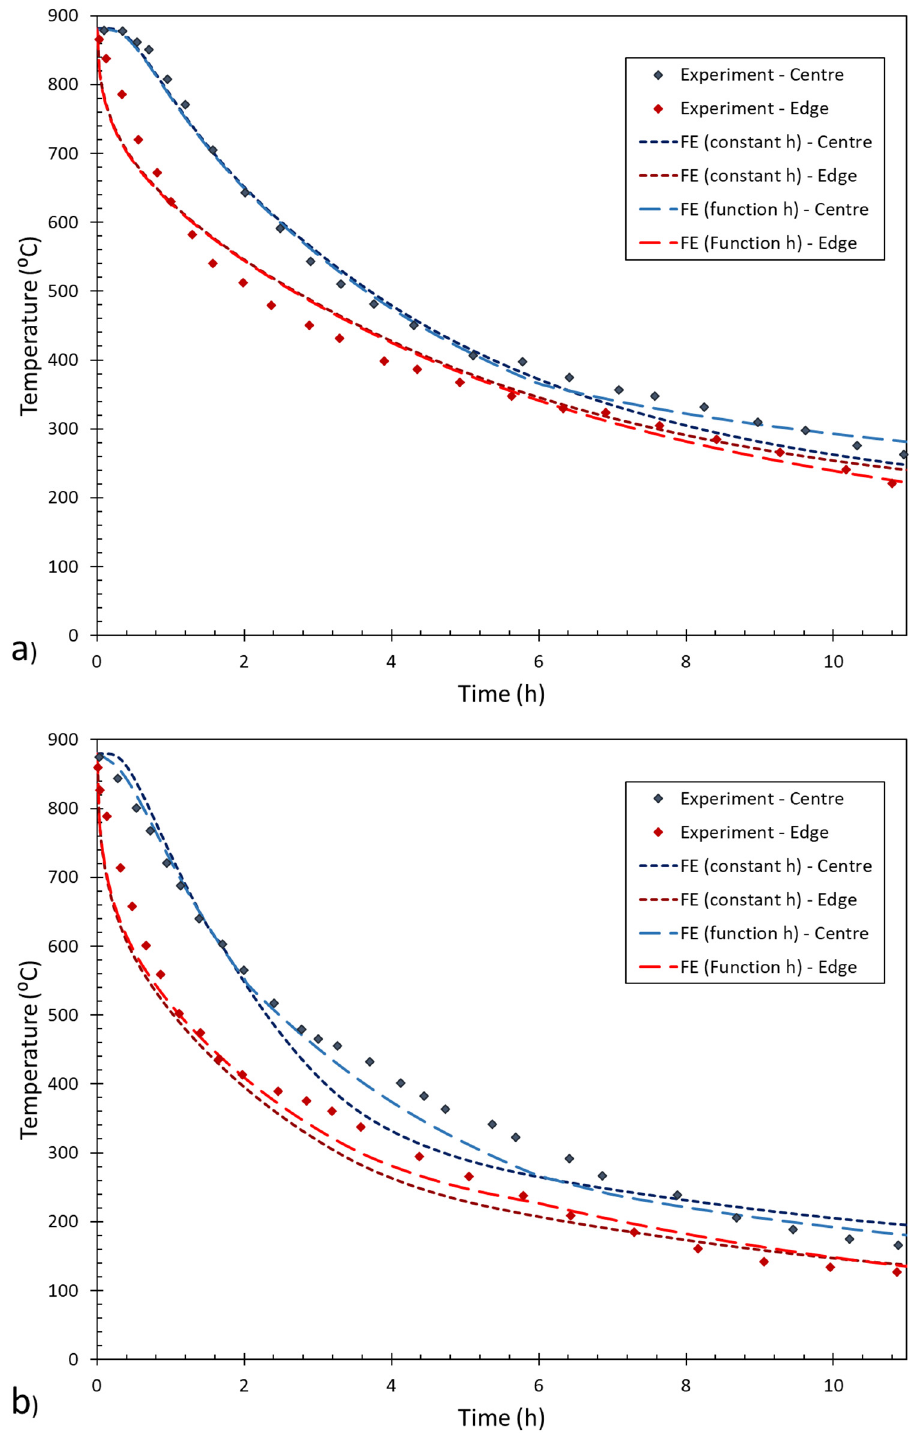
Figure 5. Cooling curves for ( a ) naturally cooled billet and ( b ) forced cooled billet; and for experiment and FE models with constant and a temperature dependent convective heat transfer term. However, this improvement only really becomes evident after approximately 7 h of cooling, whereby the temperature dependent function for h c shows a fractionally hotter billet at the centre matched by a fractionally cooler billet at the edge by roughly 30 °C. Thus, the temperature dependence of the convective term marginally affects the rate at which heat is lost from the surface and, in turn, influences the rate at which heat rebalances in the part through